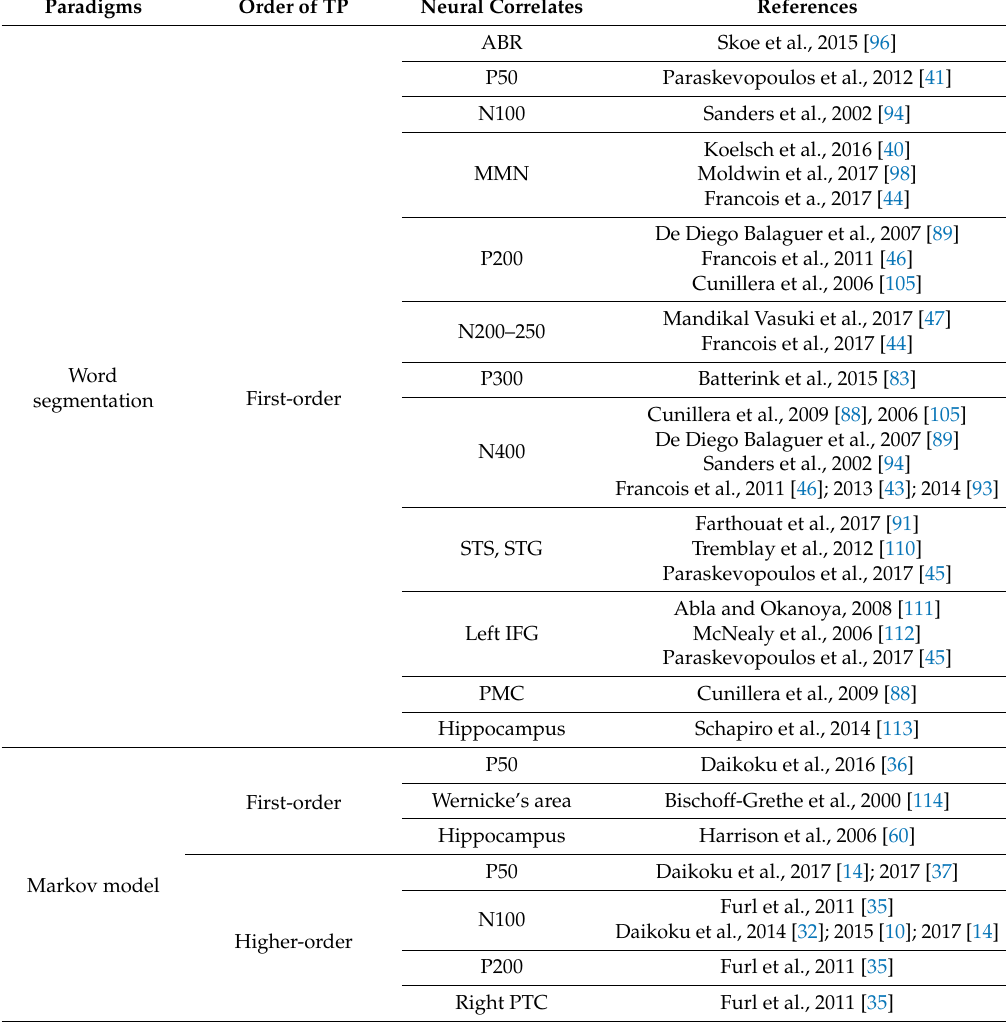
Overview of neurophysiological correlations with auditory statistical